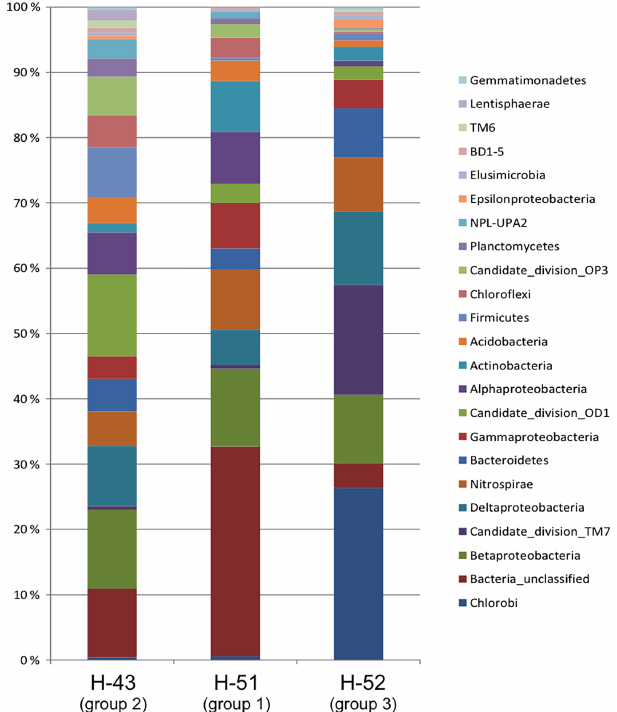
Figure 4. Phylogenetic affiliations of DNA-based bacterial 16S rRNA gene reads in percent of total reads in groundwater samples of wells H-43, H-51 and H-52 for time point May